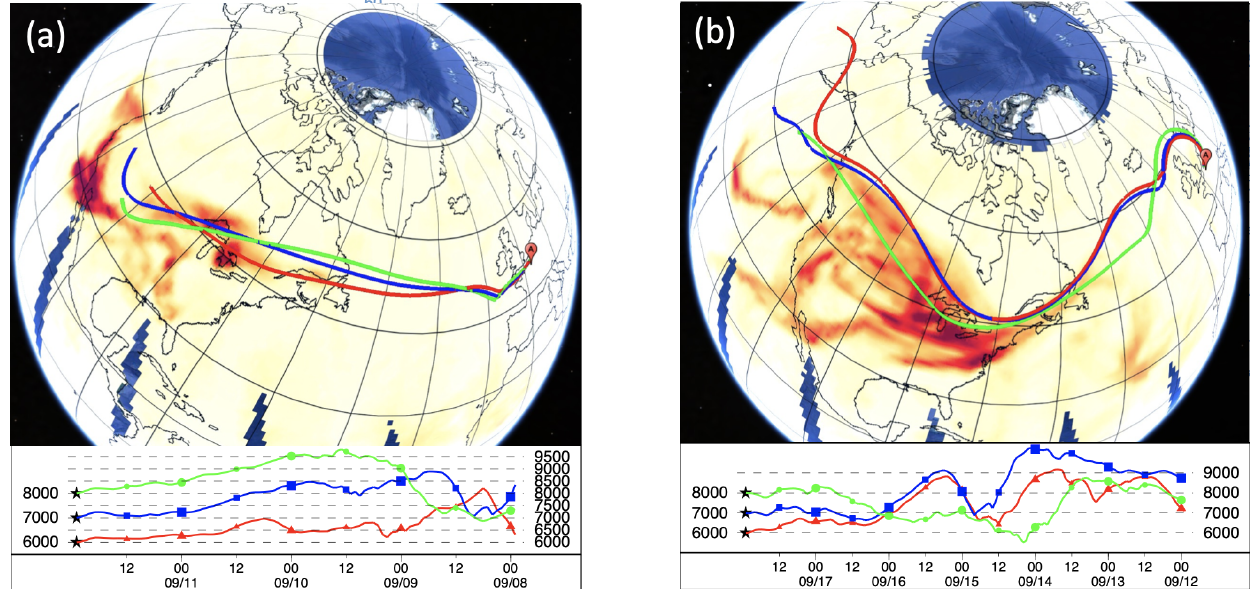
Figure 6. HYSPLIT back trajectories overlaid on the UVAI measured by OMPS onboard SUOMI-NPP satellite. The (a) 96h back trajectories ending at 00:00UTC, 12 September 2020, overlaid with UVAI on 8 September. The (b) 144h back trajectories ending at 00:00UTC, 18 September 2020, overlaid with UVAI on 14 September. © Google Earth.